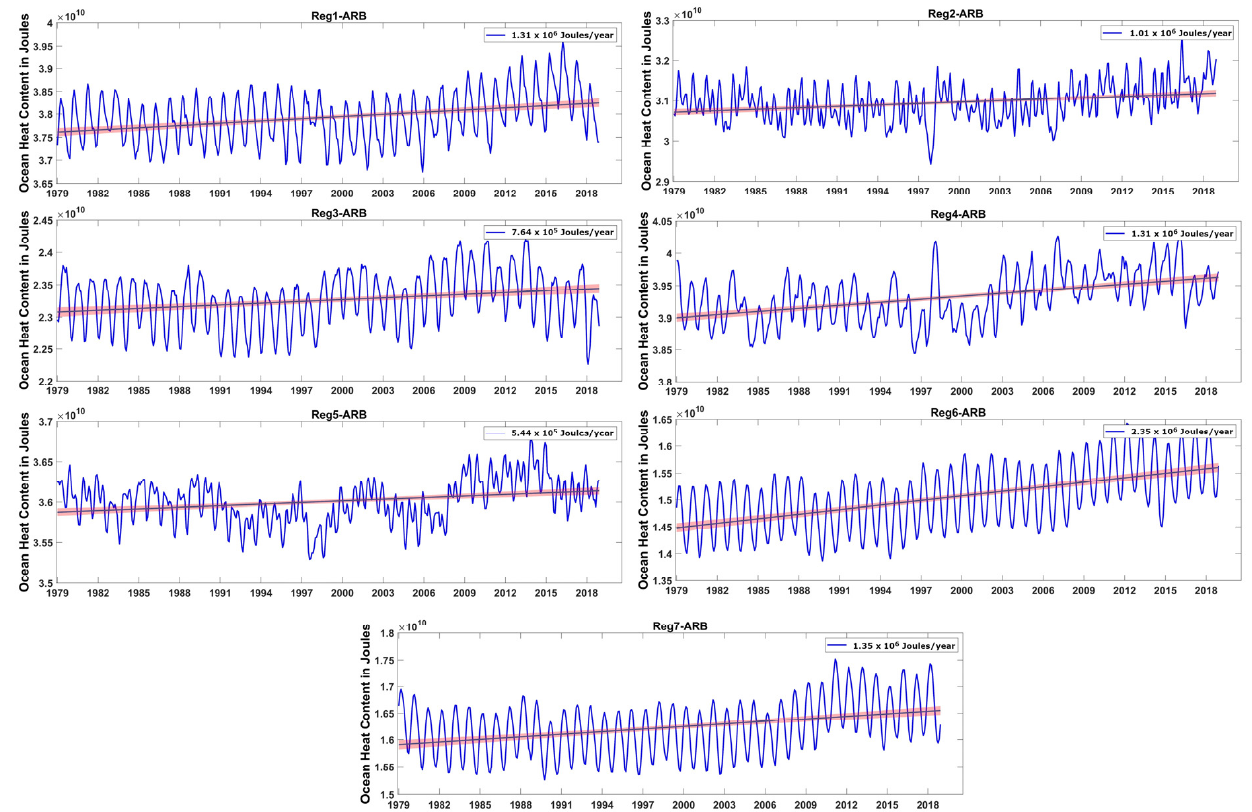
Figure 3. Variability in ORAS5 OHC at 700 m along with the corresponding confidence interval (red patches) at different sub-domains of the Indian Ocean region (1979–2020).